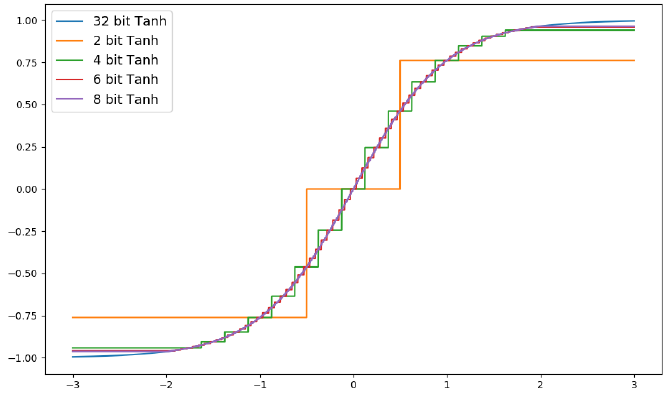
Figure 2. Hyperbolic tangent with different quantisation